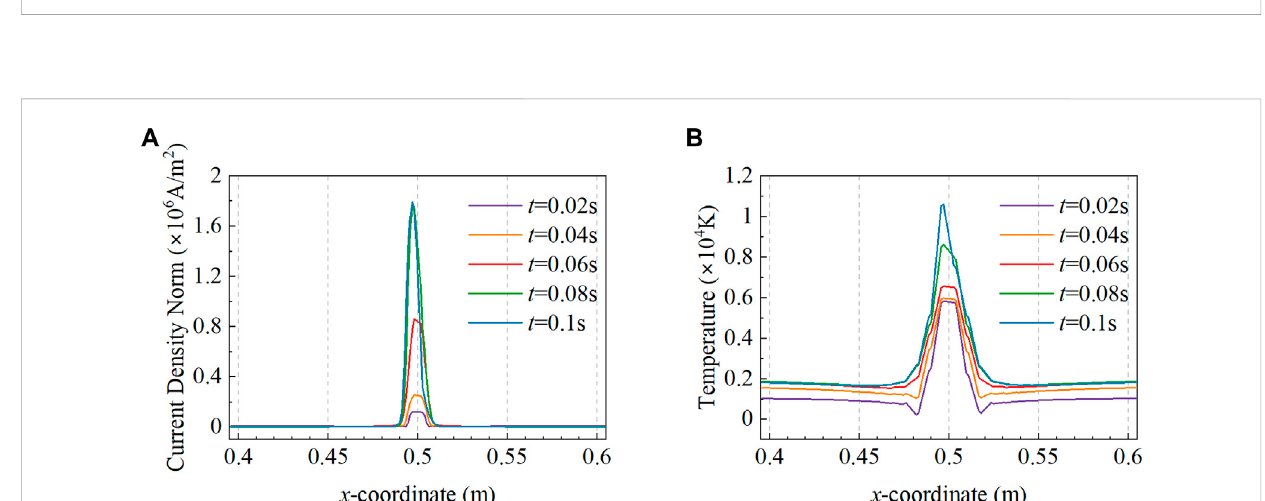
FIGURE 5 Pro fi les on the upper surface of the anode: (A) current density and (B)